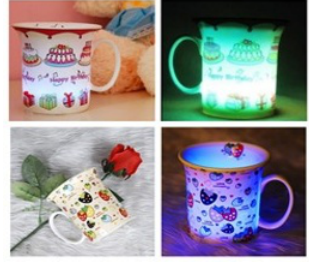
Figure 3 Untouched effect and Light effect after